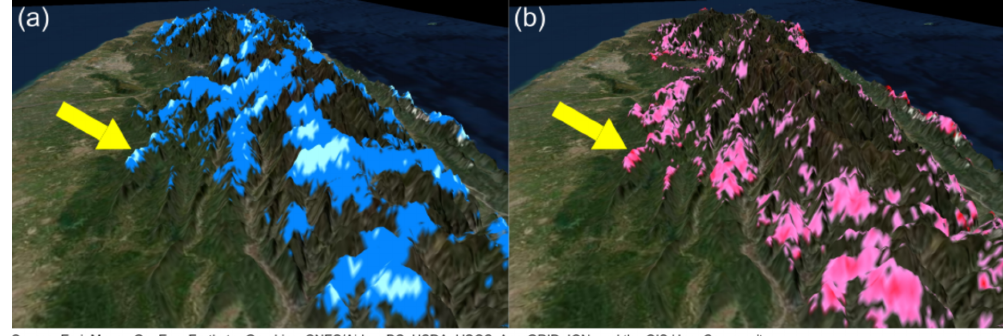
Figure 5. (a) The composite initiation time of precipitation under the clean scenario in area S. The light blue and dark blue areas represent the initiation time from 10:00 to 12:00 and from 12:00 to 13:00. (b) The area of precipitation initiation is delayed for more than 1.5h due to increasing CCN in area S. Only areas above 600m are